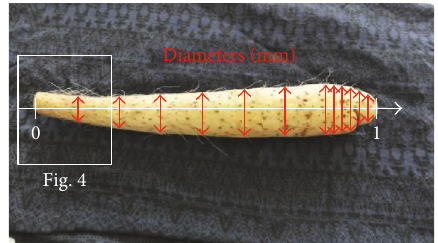
Figure 5: Step 2 . Shape of a yam, that is, all diameters {𝑦 𝑖𝑗 } ( 𝑗 = 1, 2, .. ., 𝑁 ) (both observed and estimated in Step 1 ), is predicted by a few key diameters 𝐷 𝑖 (𝑥) at 𝑥 (mm). Mean squared error between the observed diameters and the predicted diameters is calculated in order to evaluate the prediction